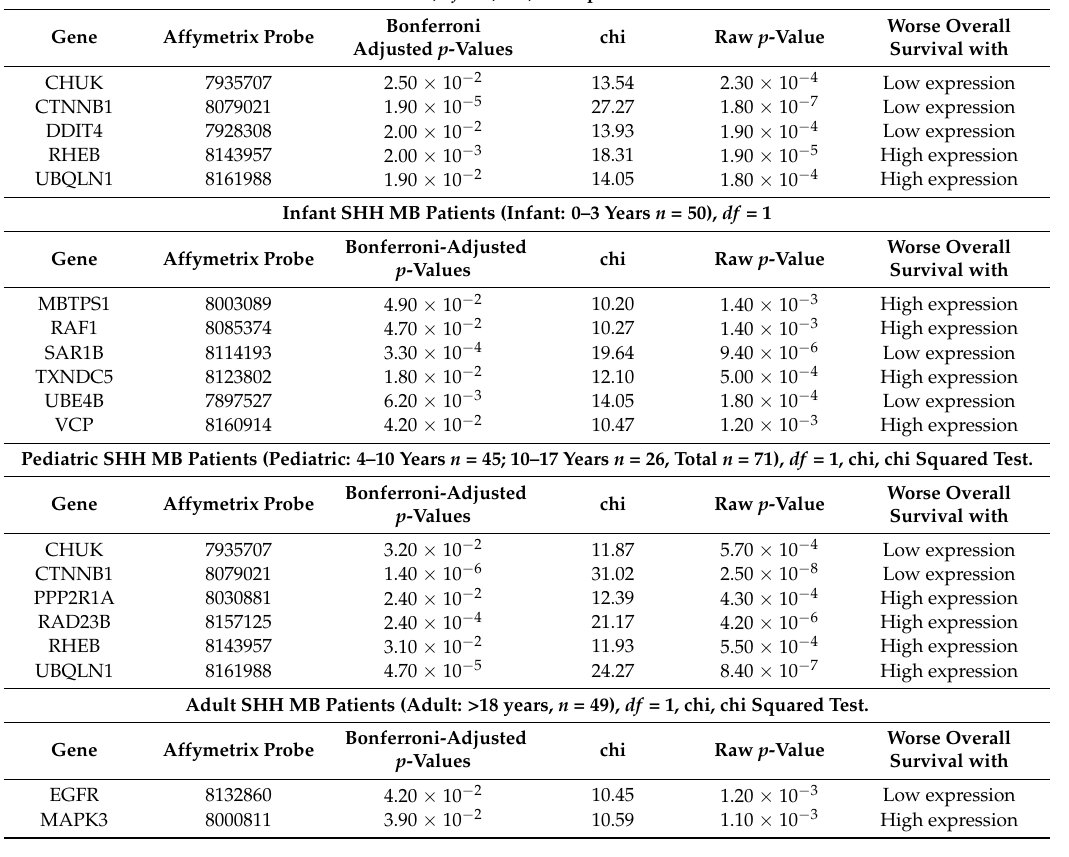
Table 7. Overall survival of SHH MB patients, divided in the four SHH subtypes (GEO ID: